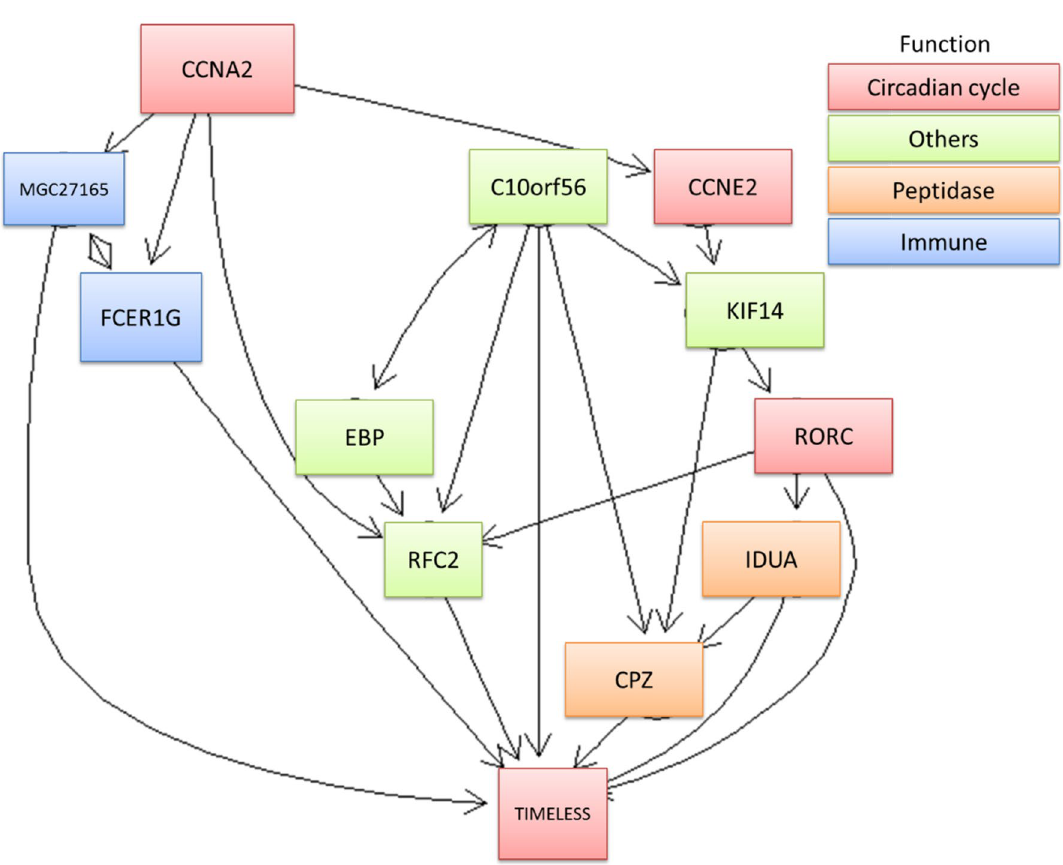
Figure 4. The predictive pathways of top 12 important co-expressed